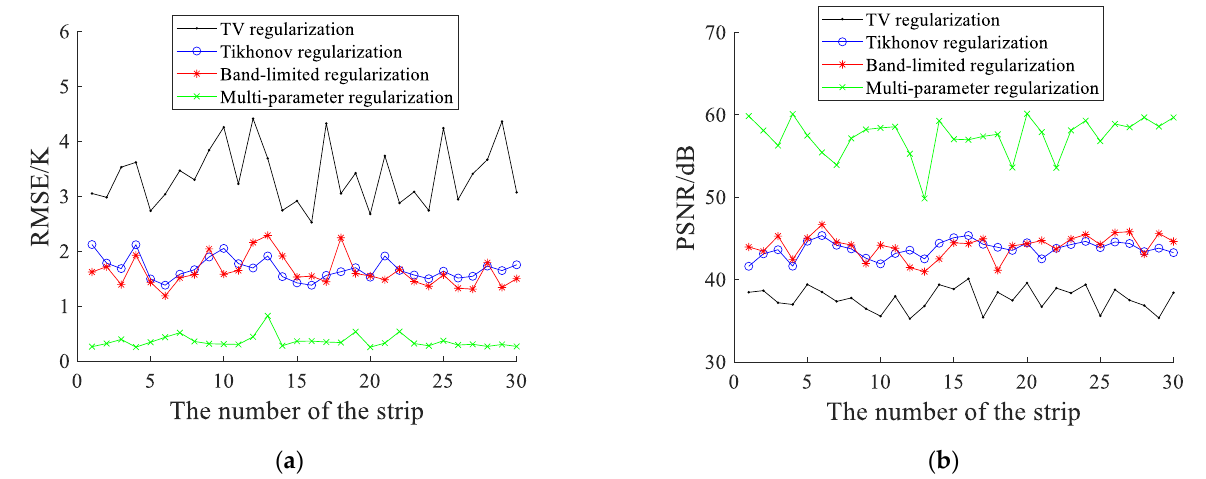
Figure 11. The relation between different strips and the performance of the regularization methods: ( a ) the root mean square error; ( b ) the peak signal to noise ratio.